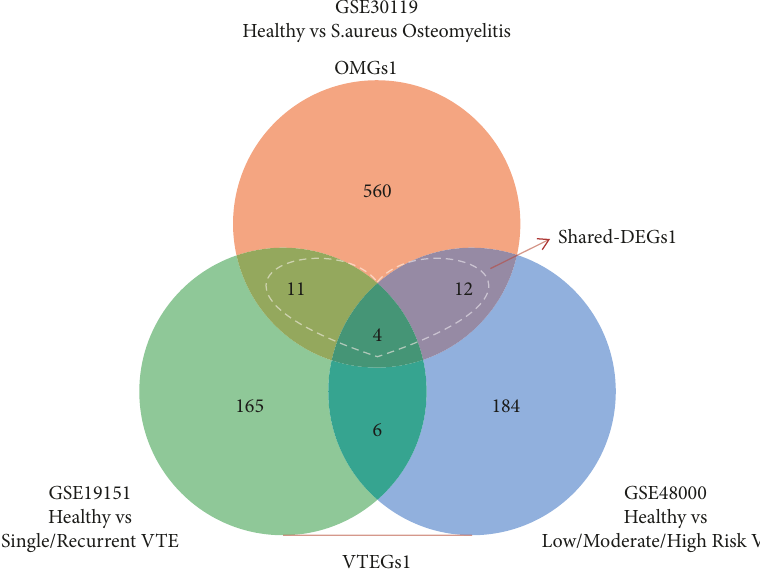
Figure 2: A Venn plot of OMGs1 and VTEGs1. Heart-shaped dotted line represents the shared